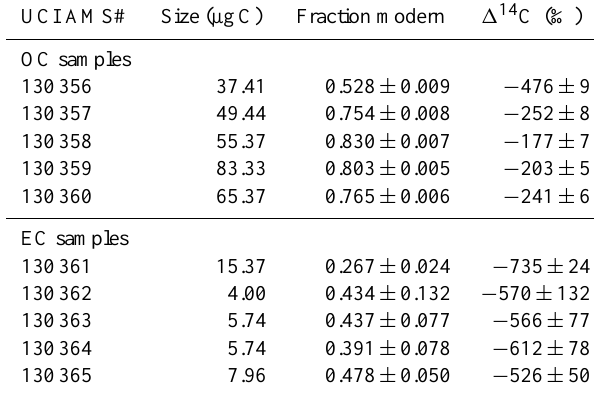
Table B1. KCCAMS analysis of intercomparison samples after background